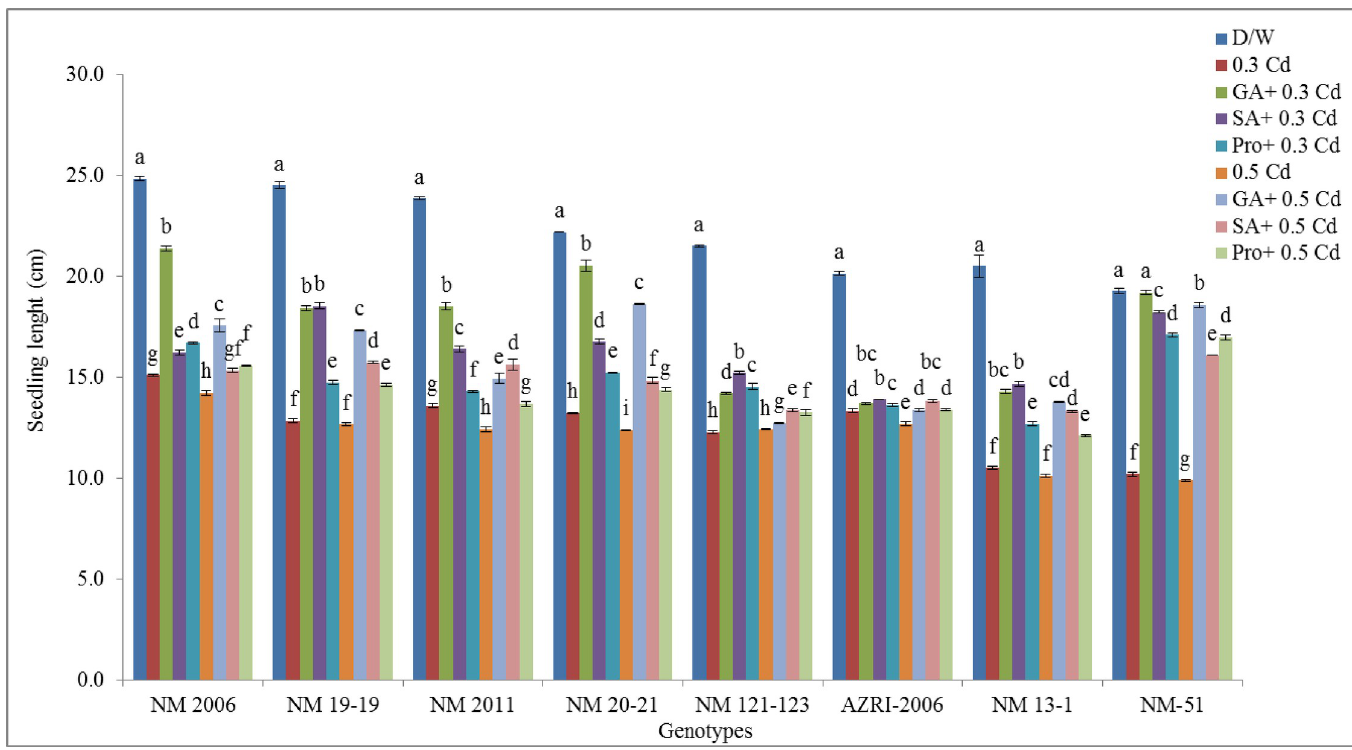
Fig 5. Mean seedling length of mung bean genotypes grown under Cd and pretreatments of GA 3 , SA and proline prior to Cd.